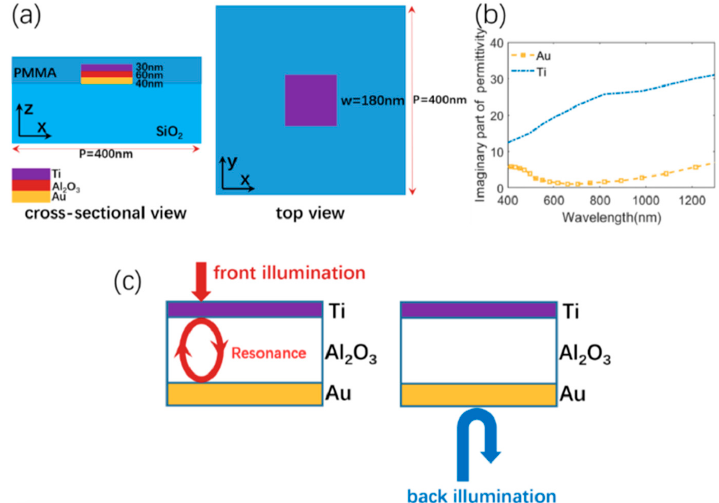
Figure 1. ( a ) Design of the visible-transparent metasurface absorber. ( b ) Imaginary parts of the permittivities for Ti and Au. ( c ) Physical mechanism for the selective near-infrared absorption for front illumination and selective near-infrared reflection for back illumination.